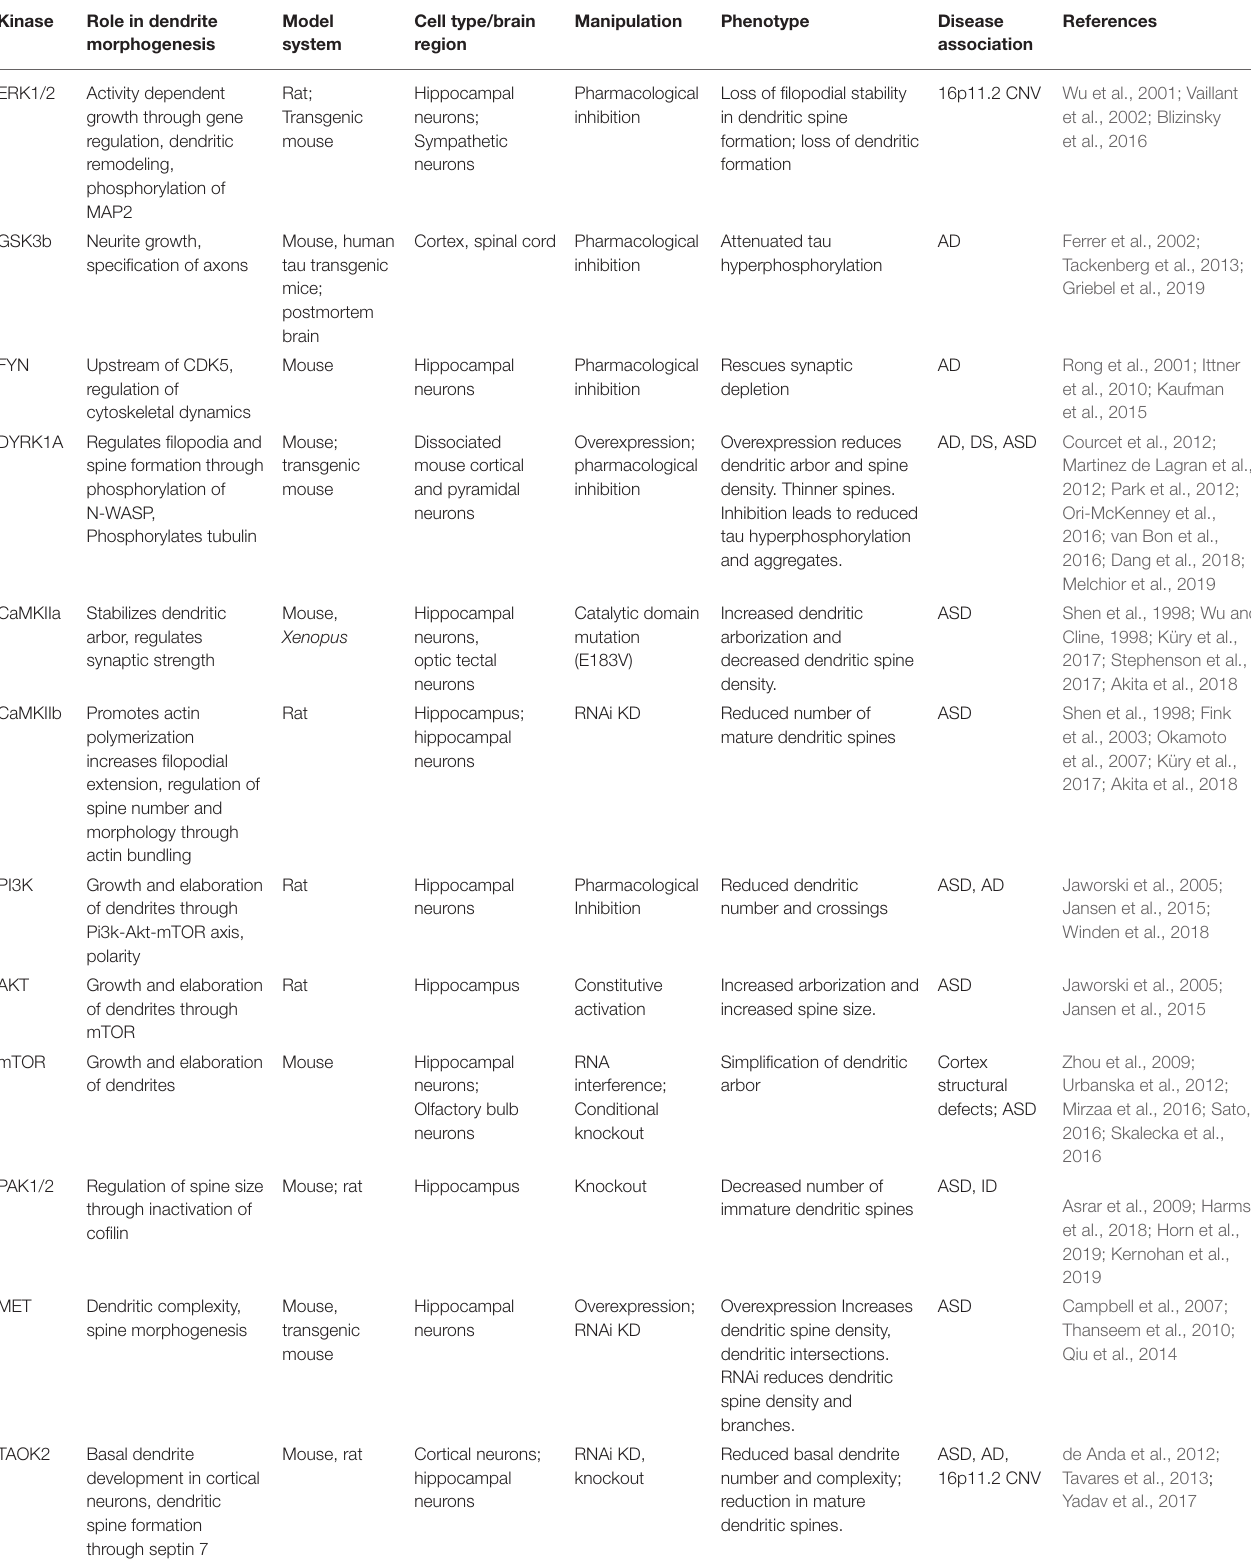
TABLE 1 | Kinase signaling pathways implicated in neurological diseases and their role in dendrite